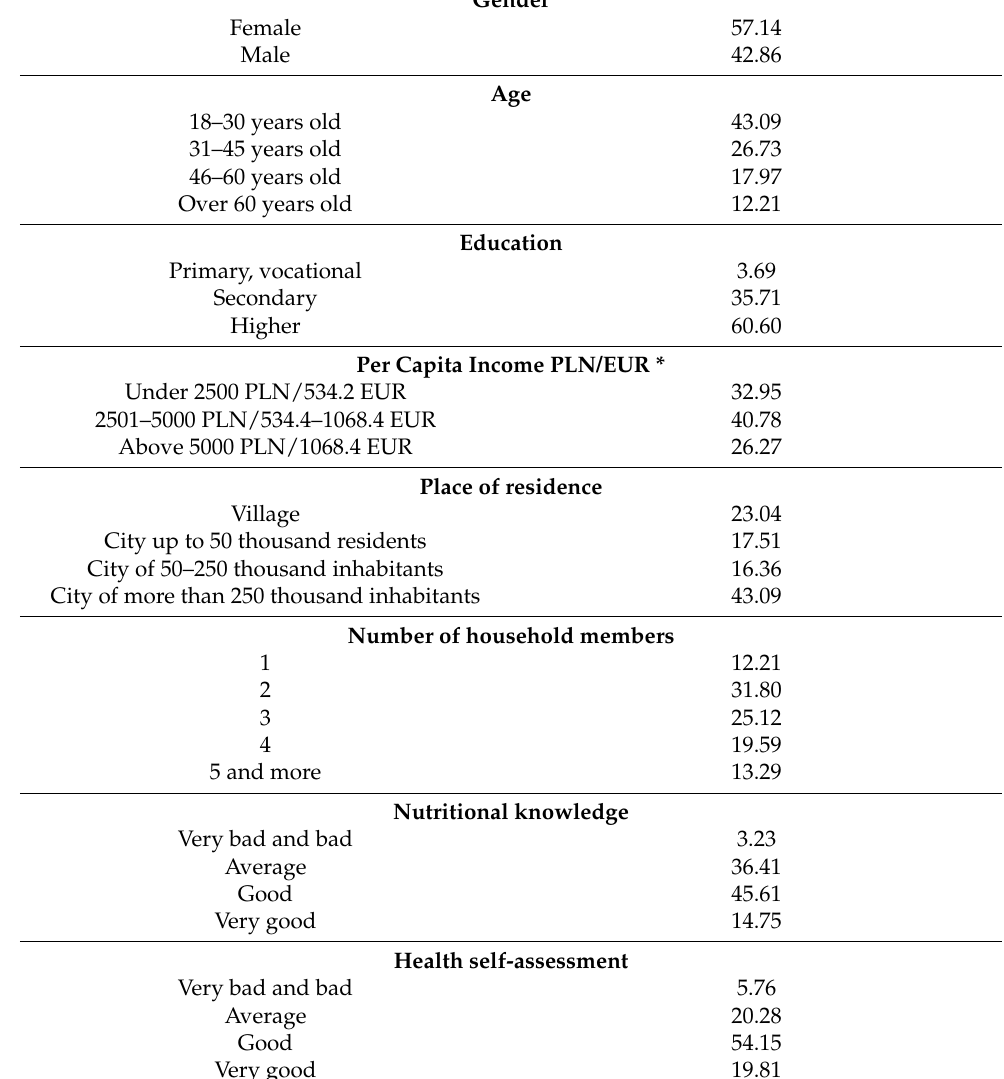
Table 1. Sample characteristics (n = 487, data in